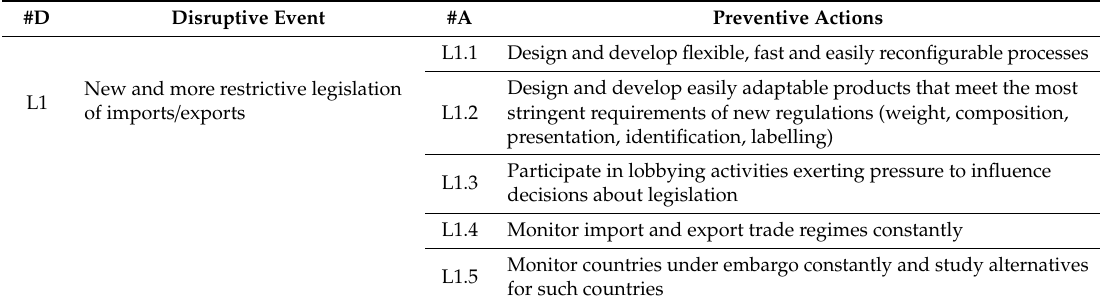
Table 9. Summary of disruptive events related to environmental and context-related aspects and preventive